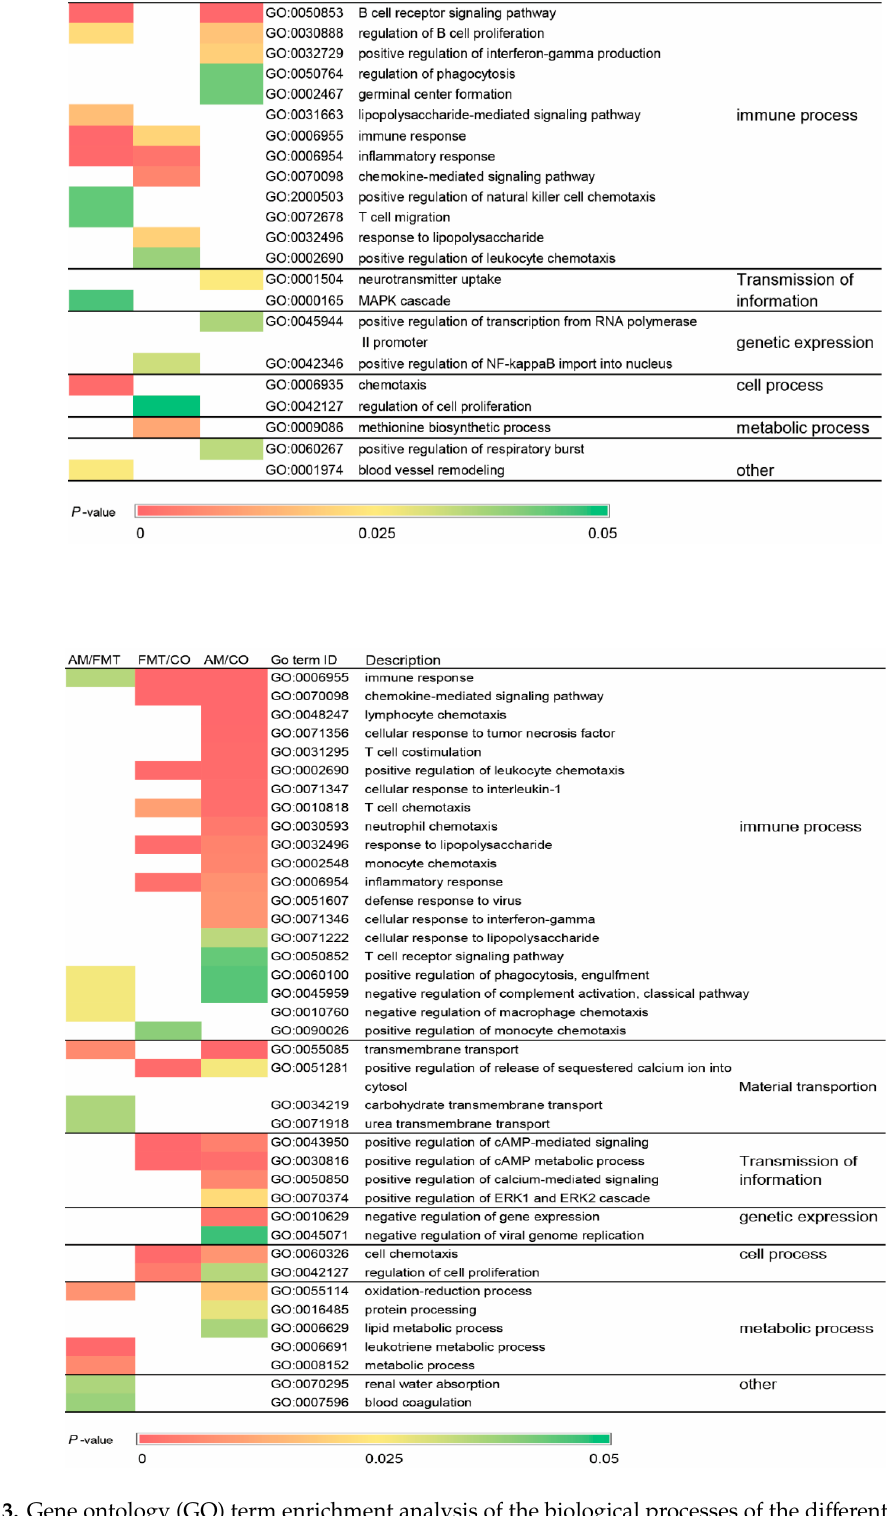
Figure 3. Gene ontology (GO) term enrichment analysis of the biological processes of the di ff erentially expressed genes in the ileum mucosa of pigs induced by the amoxicillin (AM), fecal microbiota transplantation (FMT), and control (CO) groups on ( A ) days 7 and ( B )